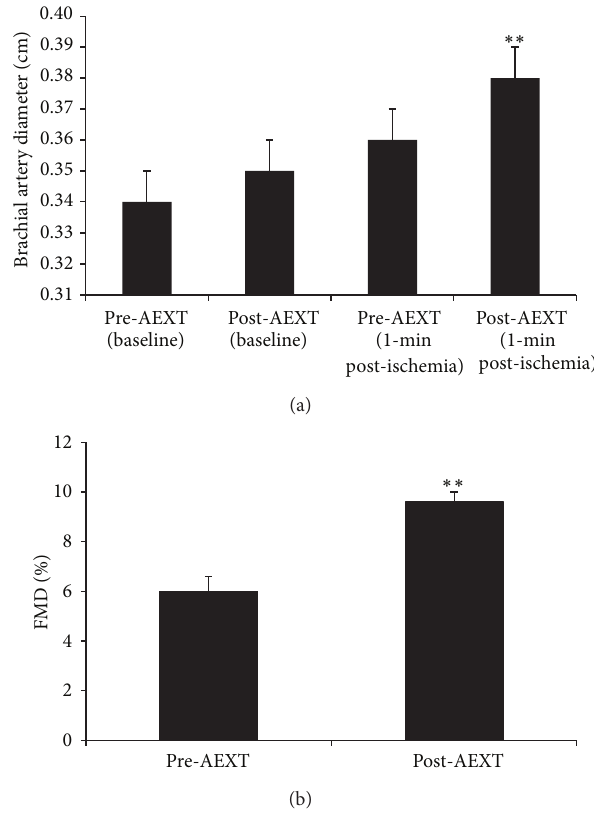
Figure 1: Measures of brachial artery diameter and endothelial function before and after AEXT. The upper panel (a) shows brachial artery diameter at baseline and at 1-minute post-ischemia pre- and post-AEXT. The lower panel (b) shows FMD% pre- and post-AEXT. Bars are expressed as mean ± SEM. ∗∗ Denotes significant differences pre- versus post-AEXT; 𝑃 < 0.01